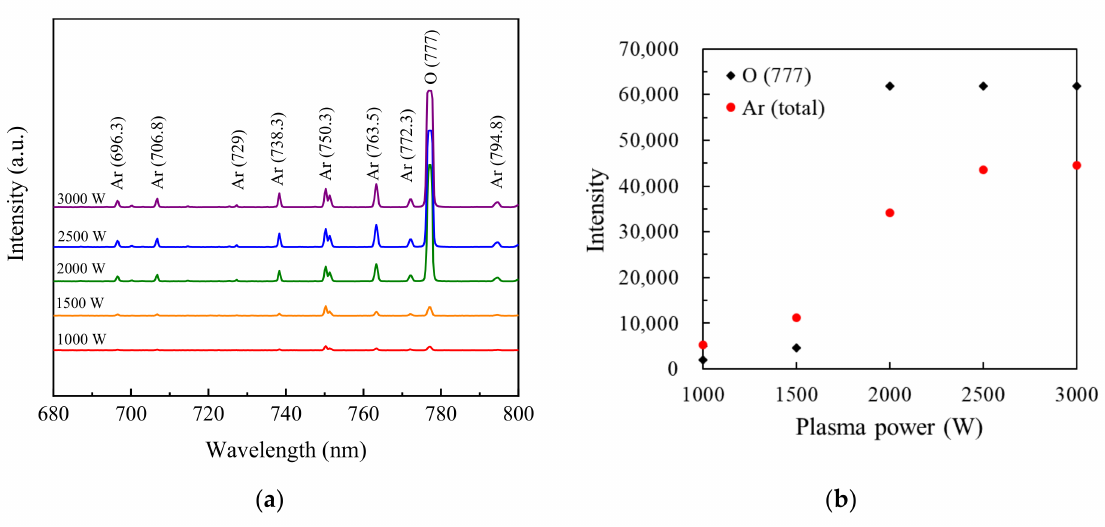
Figure 2. ( a ) OES spectra for SiO 2 thin films prepared with O 2 /Ar mixture plasma at different plasma powers; ( b ) summed intensity for Ar ions and O radical spectra at various plasma